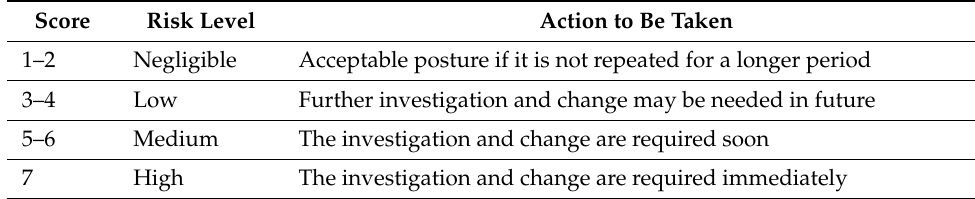
Figure 3. RULA Scoring Mechanism. Table 2. RULA Risk level.